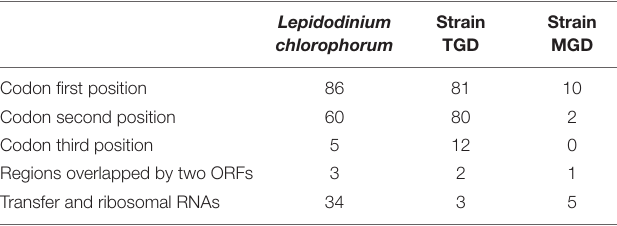
TABLE 3 | Frequencies of base conversion-type RNA editing at the codon positions in the three